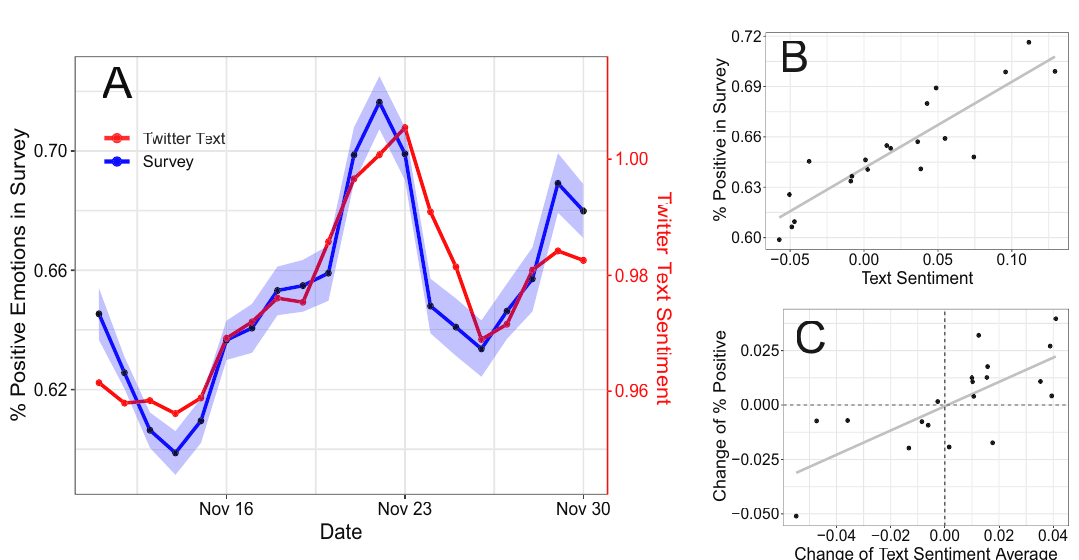
Figure 2. ( A ) Time series of the daily percentage of positive mood reported in the survey and the aggregated sentiment of user-generated text on Twitter in Austria. The shaded blue area corresponds to 95% bootstrapped confidence intervals. ( B ) Scatterplot of text sentiment and survey responses with regression line. ( C ) Scatterplot of the daily changes in both text sentiment and survey responses compared to the previous day, with regression